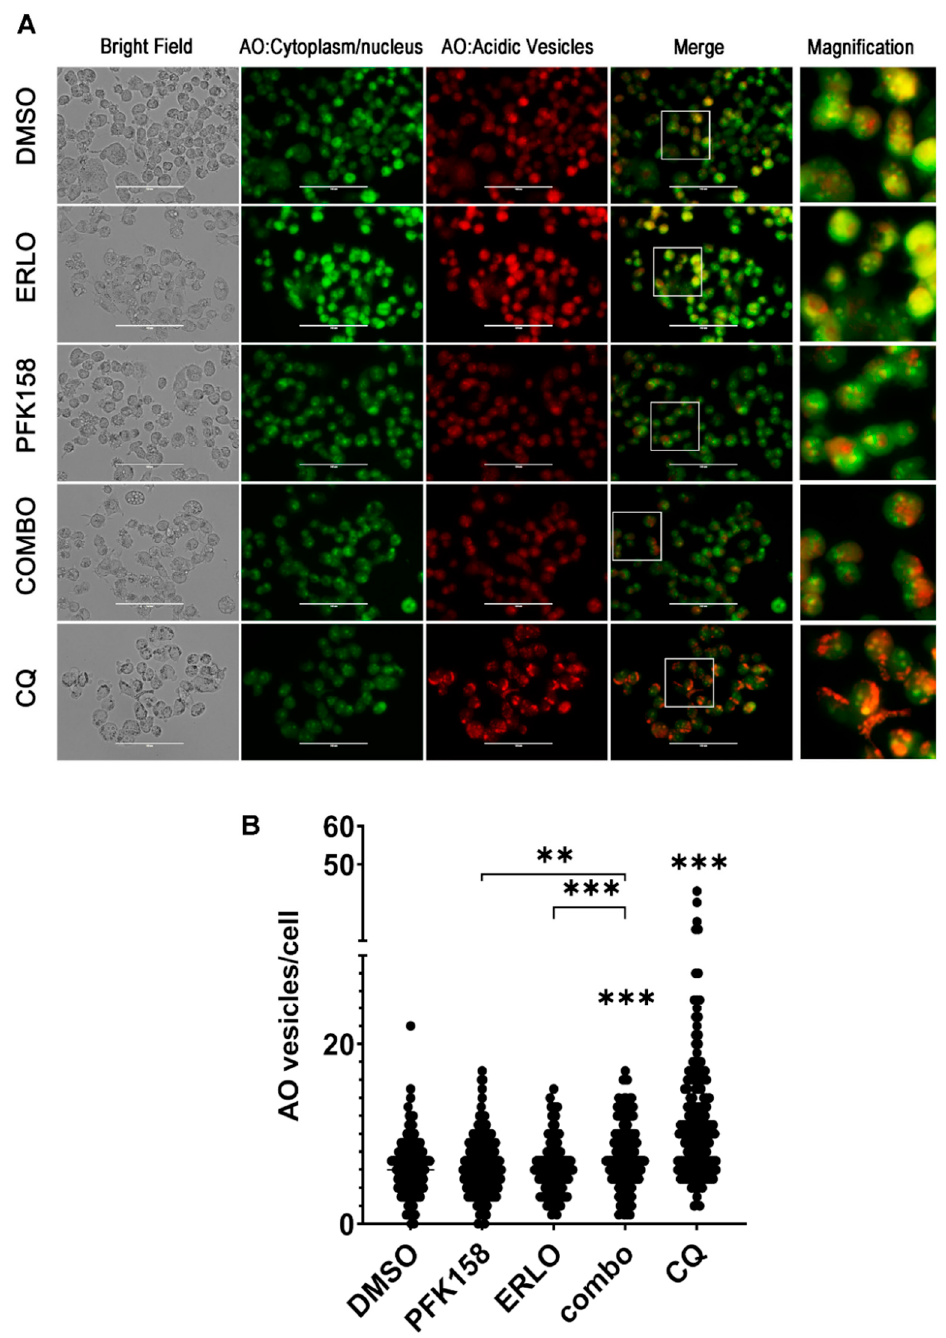
Figure 5. Dual treatment promotes the accumulation of non-released acidic vesicular organelles (AVOs) in WT EGFR H522 cells. H522 cells were exposed to 2 µ M erlotinib and 0.75 µ M PFK158 alone or in combination for 48 h. Cells treated with chloroquine (CQ, 20 µ M) were used as positive control for proper AVO accumulation and labeling. AVO accumulation was evaluated by acridine orange staining. Images were taken at 20 × magnification with an EVOS FL Imaging System microscope ( A ). Images are representative of two independent experiments. Bright field images illustrate cell morphology and AO accumulation in dark vesicles. Under fluorescence, acridine orange staining in the cytoplasm and nucleus fluoresce green, whereas the acidic compartments fluoresce bright red or orange-red. Scale bar: 100 µ m. The number of AO positive vesicle per cell was counted using Image J ( B ), p values are shown as follows: ** < 0.01, *** < 0.001, (compared to DMSO or indicated treatment).